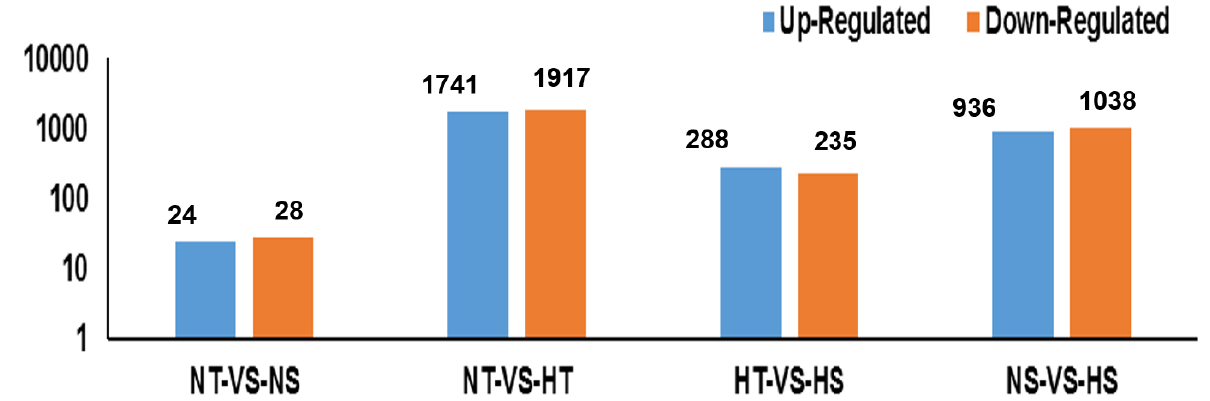
Figure 7. The number of differentially expressed genes (DEG) with or without Spd treatment under normal conditions or heat temperature stress. Summary of DEGs between NT and NS, NT and HT, HT and HS, and NS and HS. NT, normal growth condition under 25/18 °C and water; NS, normal growth condition under 25/18 °C with 1 mM Spd treatment on plants; HT, high temperature growth condition on 38/28 °C and water treatment; HS, high temperature growth condition on 38/28 °C with 1 mM Spd treatment on leaves.